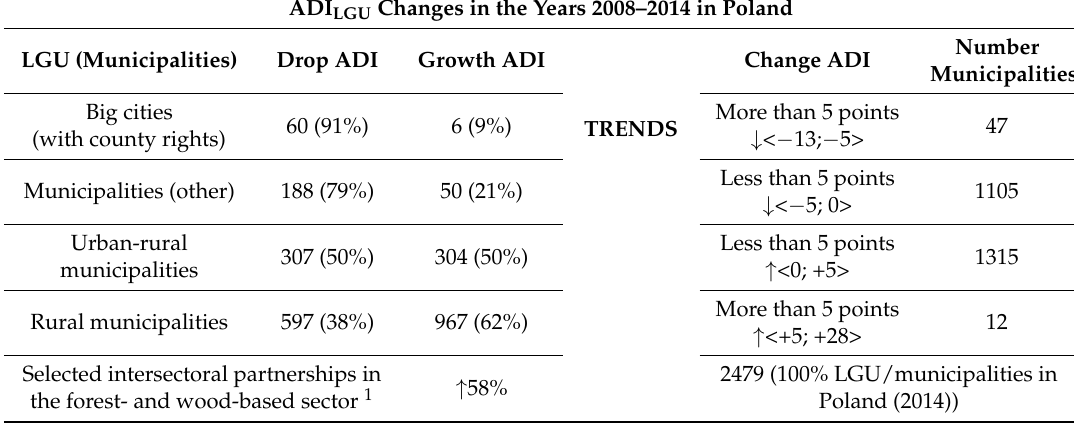
Table 1. Changes to the Aggregated Development Index ADI LGU value in the years